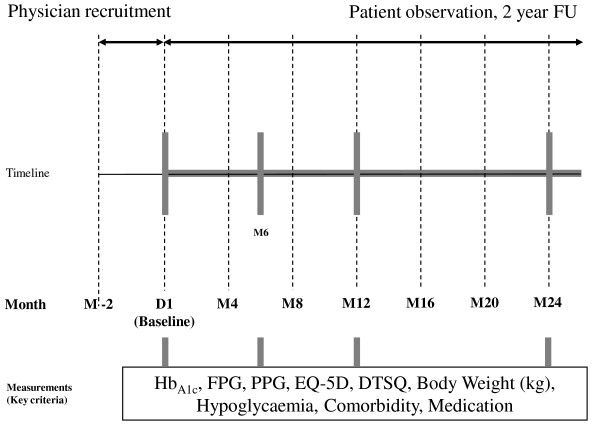
Graphical study design. M, month(s); FU, follow-up; D, Day; FPG, fasting plasma glucose; PPG, post-prandial glucose; EQ-5D, EuroQol-5D; DTSQ, Diabetes Treatment Satisfaction Questionnaire